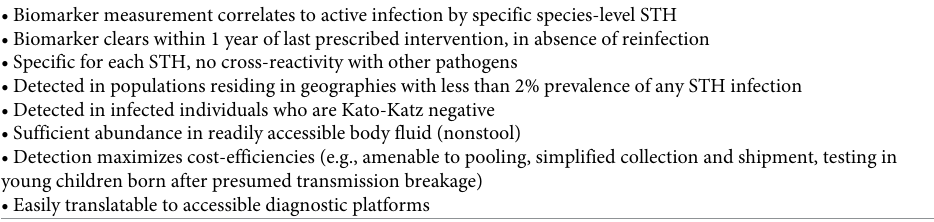
Table 4. General desired characteristics of use-case #3 and #4